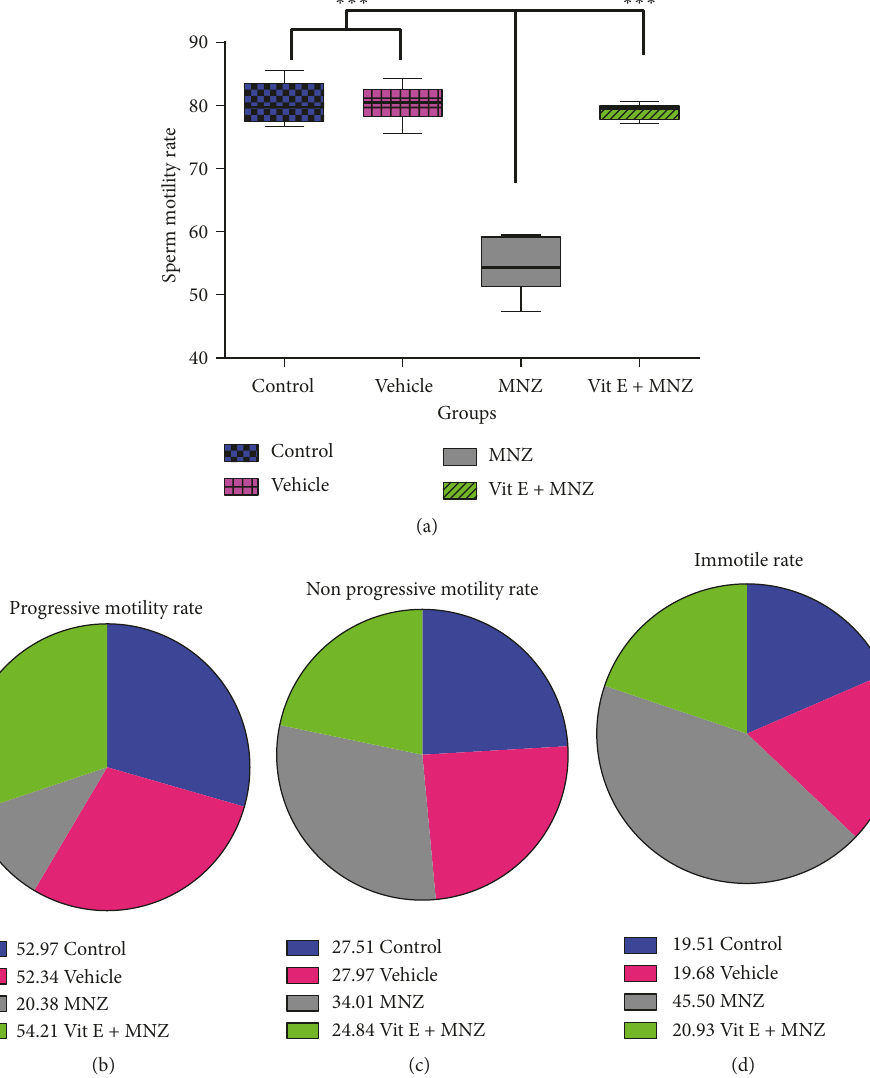
Figure 3: The effect of mancozeb administration alone and with vitamin E during intrauterine life and lactating periods on sperm motility (a) and progression (b–d) in the different groups (n=10). The percentageof progressive motile sperm was lowest level in MNZ group, whereas this value in vit.E+MNZ group was near to those of control and vehicle groups (b). The immotile sperm rate was highest in MNZ group (d). MNZ: mancozeb. ∗ ∗ ∗ indicates p <